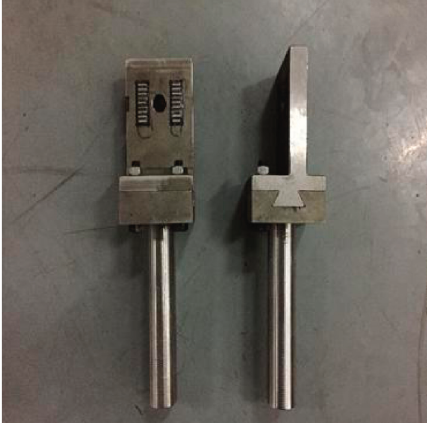
Figure 4: Testing